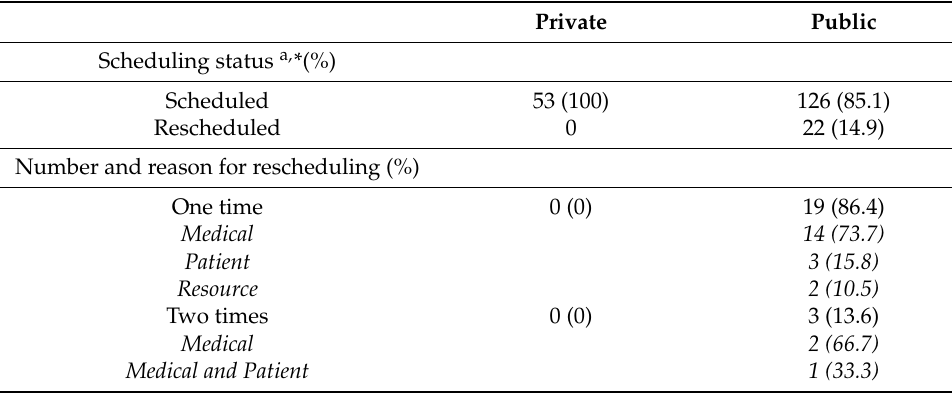
Table 3. Rate and reasons for cataract surgery rescheduling.